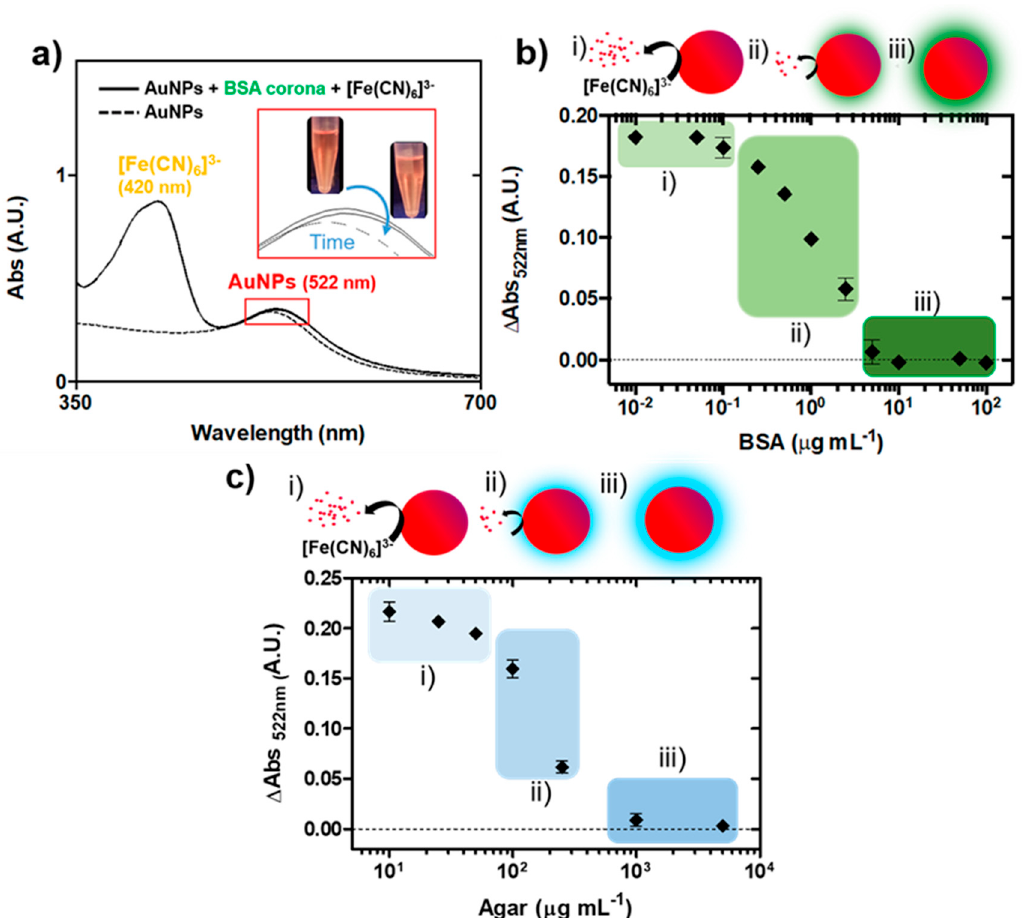
Figure 3. Modulation of ferricyanide dissociation by biocoronas. ( a ) Time evolution of the UV-vis spectra of BSA-coated AuNPs with ferricyanide (dashed line corresponds to untreated NPs). Inset, images showing the colour evolution of the AuNP suspension. ( b ) Absorbance variation at 522 nm of AuNPs (with respect to untreated NPs) exposed to BSA concentrations ranging from 0.01 to 100 µg mL − 1 after reaction with ferricyanide. The concentration ranges corresponding to low, medium and maximum inhibition of the catalytic activity are indicated by (i), (ii) and (iii), respectively. ( c ) Absorbance variation at 522 nm of AuNPs (with respect to untreated NPs) exposed to agar concentrations ranging from 10 to 5000 µg mL − 1 after reaction with ferricyanide. The concentration ranges corresponding to low, medium and maximum inhibition of the catalytic activity are indicated by (i), (ii) and (iii), respectively. (error bars represent the standard deviation, n = 3).